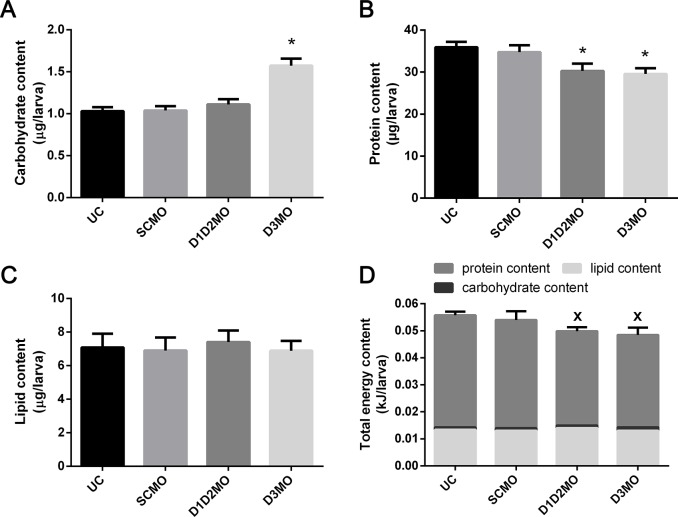
Effect of deiodinase knockdown on energy status of zebrafish larvae.(A) carbohydrate content, (B) protein content, (C) lipid content, and (D) total energy content in zebrafish larvae at 72 hpf. Data are shown as average ± SD and SD was calculated over four biological replicate samples. Error bars in (D) show SD of total energy content. * indicates a significant difference from SCMO. X indicates a significant difference from the total energy content of UC. D1D2MO: combination of deiodinase type 1 and type 2 morpholino-injected, D3MO: deiodinase type 3 morpholino-injected, UC: uninjected control. SCMO: standard control morpholino-injected.